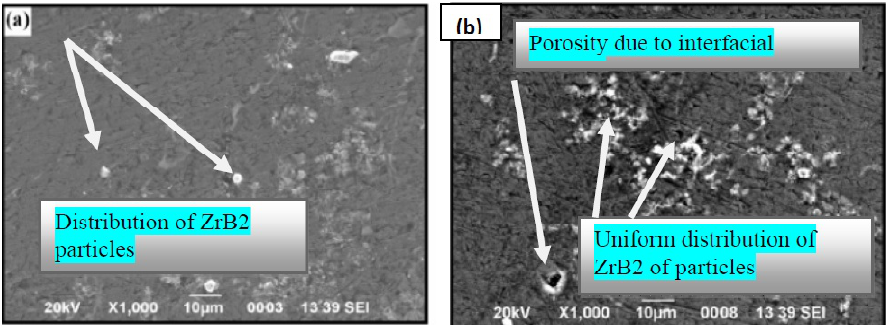
Fig. 6 SEM micrograph of AA6061 MMCs 5% ZrB